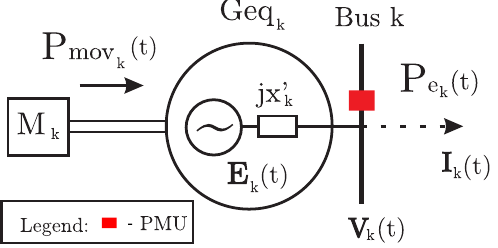
Figure 3. Equivalent generator estimated from the retained bus k